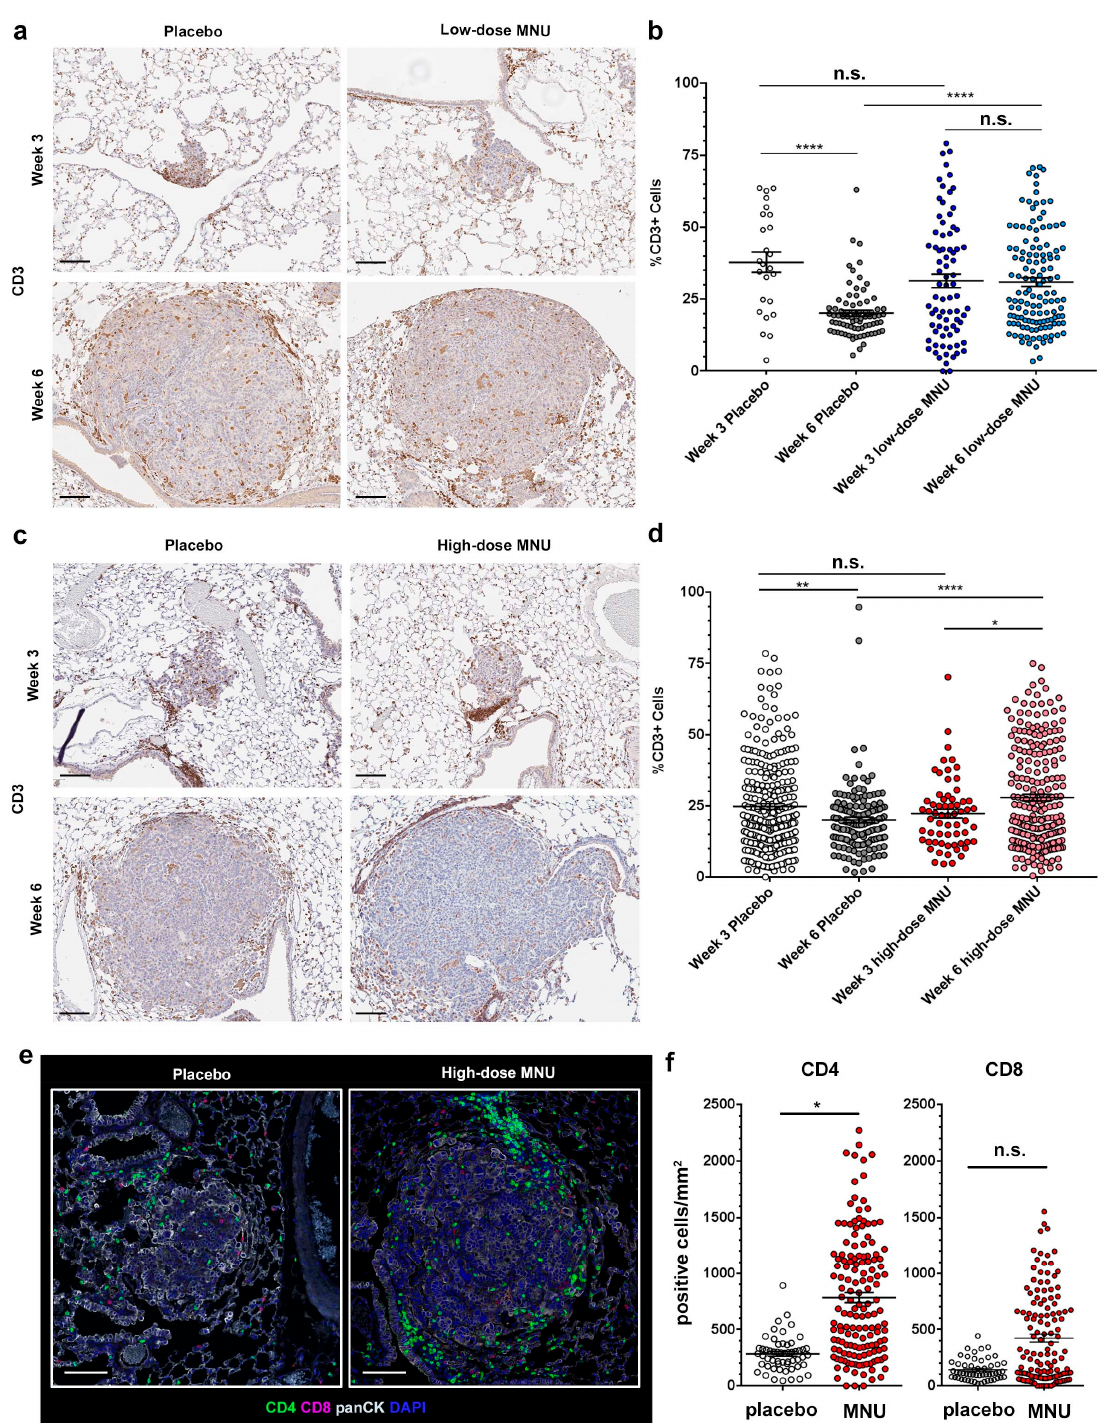
Figure 2. MNU treatment causes sustained lymphocyte infiltration in KP tumors. KP mice were treated with low-dose or high-dose MNU for either 3 or 6 weeks, followed by lung extraction and fixation for immunohistochemistry. At both time points, each MNU regimen had a corresponding placebo group. TIL number was evaluated by immunohistochemistry for CD3. ( a ) Representative pictures of CD3 staining in KP tumors treated with either placebo or low-dose MNU, as indicated. ( b ) Quantification of the number of TILs in each tumor of the placebo and low-MNU group at 3 and 6 weeks, as measured by percentage of CD3-positive cells in the tumor section. The measurement was made with QuPath software by identifying total cells based on the hematoxylin counterstain and then quantifying the DAB signal in each cell. ( c ) Representative pictures of CD3 staining in KP tumors treated with either placebo or high-dose MNU, as indicated. ( d ) Quantification of the number of TILs in each tumor of the placebo and low-MNU group at 3 and 6 weeks, as measured by percentage of